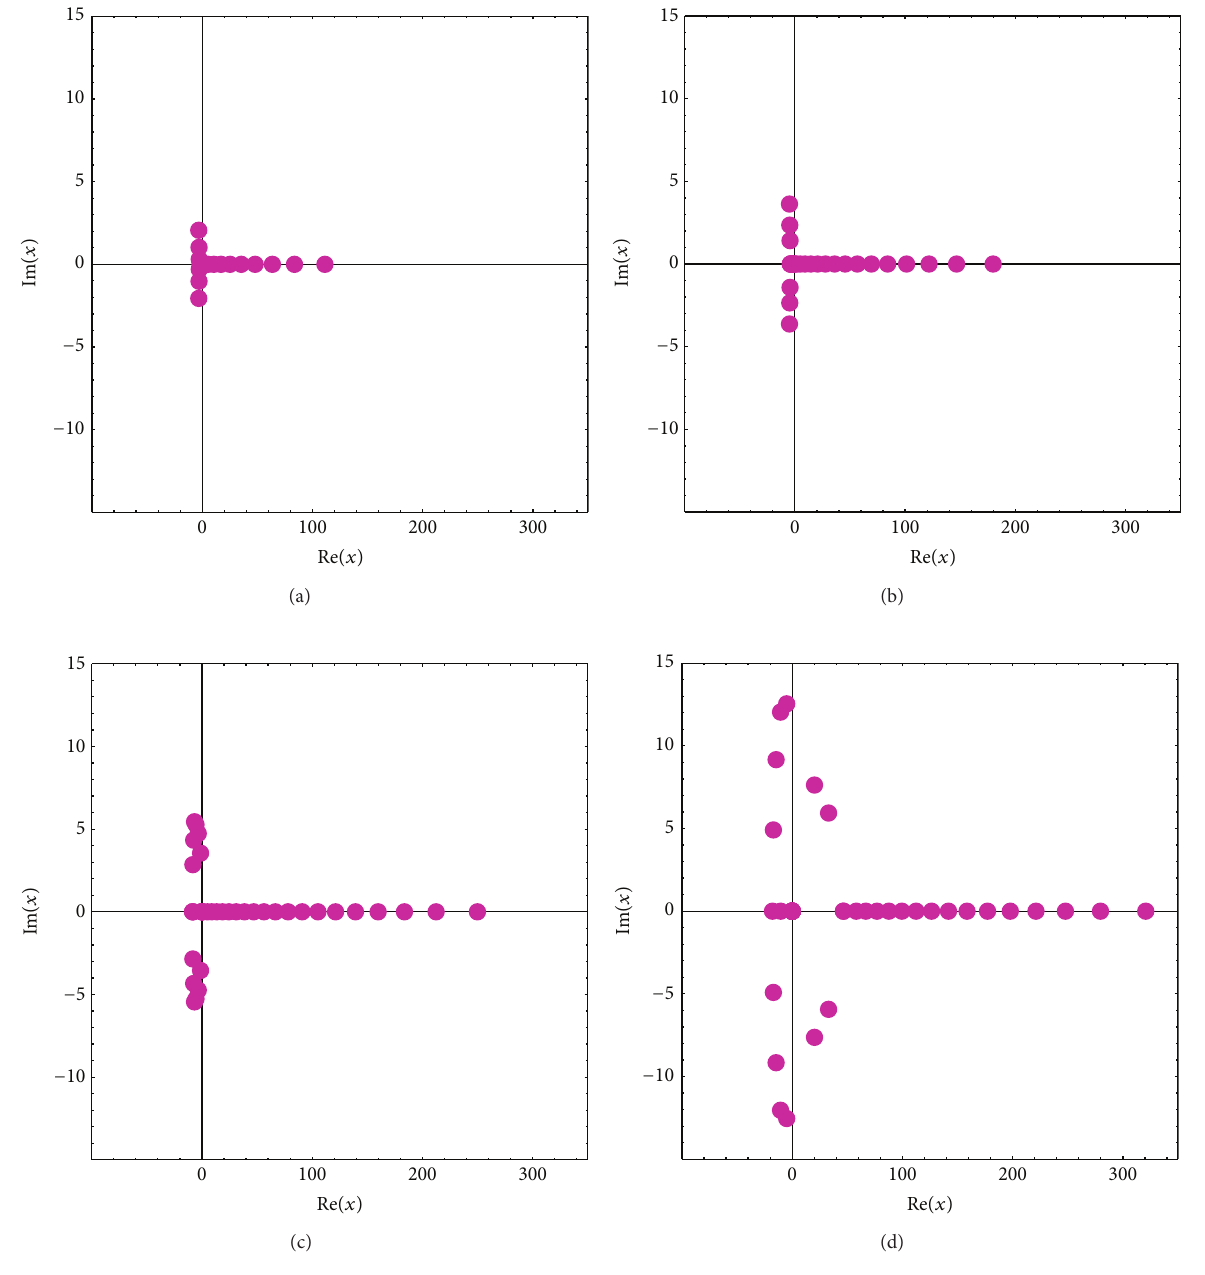
̃𝑈 (𝑥) for 𝑛 = 20, 30, 40, 50 𝑛